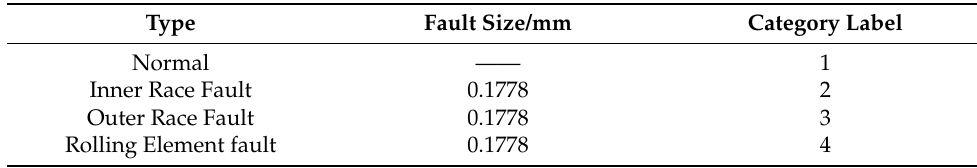
Figure 5. The time domain waveforms of vibration signals under four bearing states. Table 1. A description of the bearing dataset.